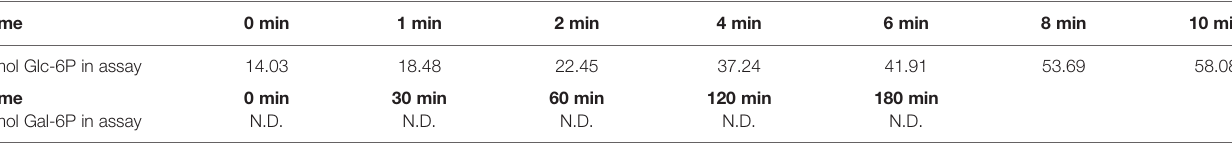
TABLE 1 | Product formation of Glc-6P from Glc-1P in an enzyme assay over 10 min measured by GC-MS.